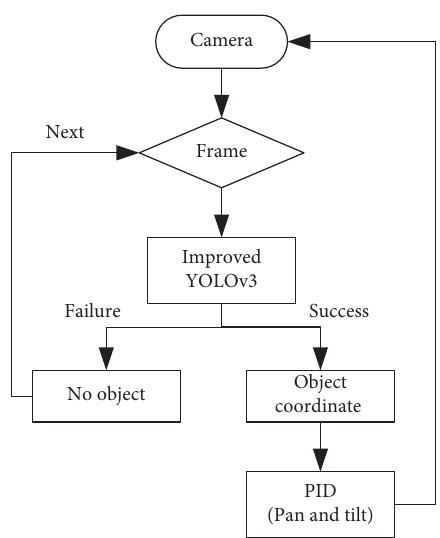
Figure 5: PID control